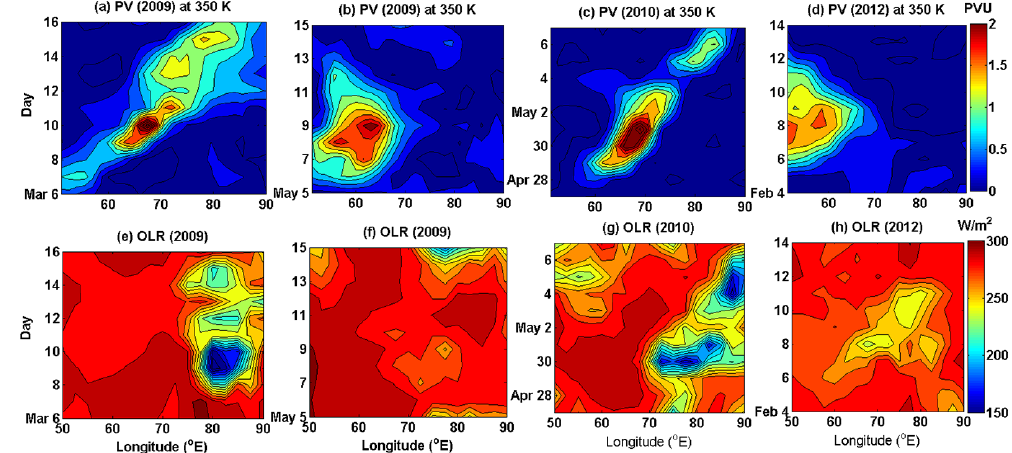
Figure 1. Longitude-time cross sections of PV at 350K isentropic level at 13.5 ◦ N and OLR averaged over 12.5–15 ◦ N for the years 2009, 2010 and 2012.